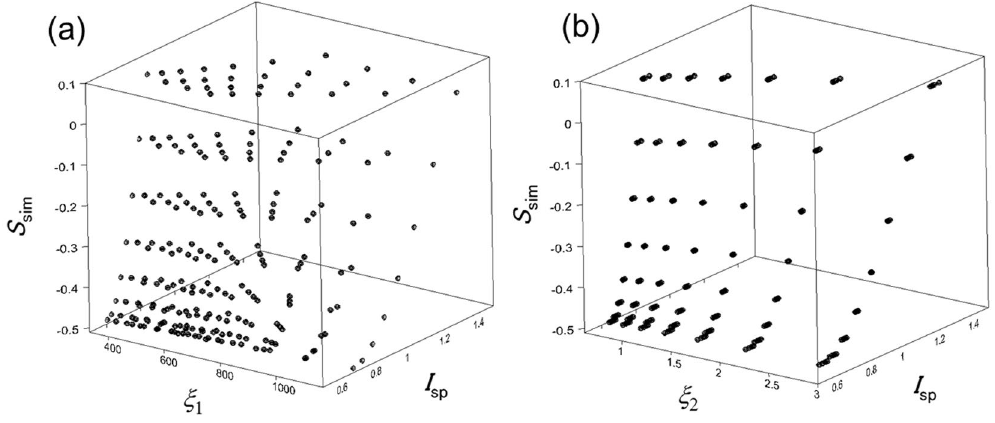
Figure 2. Simulated results of S sim obtained by I sp and ( a ) ξ 1 or ( b ) ξ 2